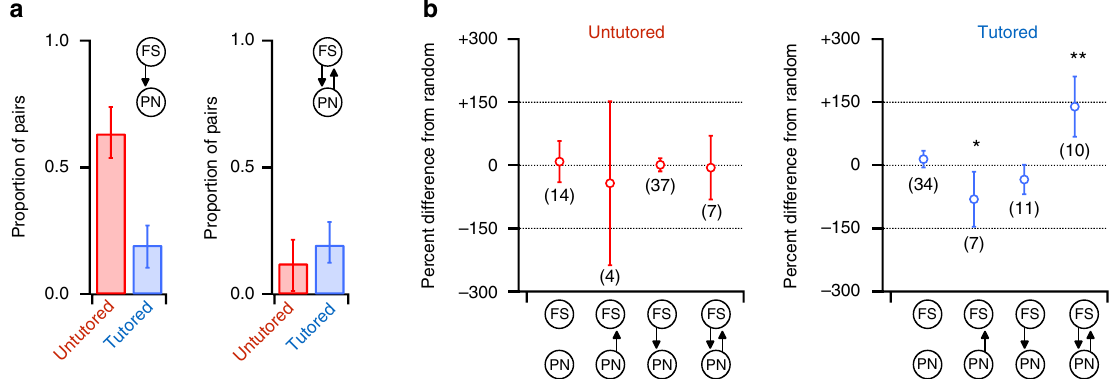
Fig. 3 Enrichment of reciprocal FSI ↔ PN connections during song learning. a Proportion of all tested pairs before (red) and after (blue) tutoring that were unidirectional FSI → PN connections (left) or reciprocal FSI ↔ PN connections (right). Song learning was associated with a 69% reduction in unidirectional FSI → PN connections (binomial test p < 0.001), but did not alter the proportion of reciprocal FSI ↔ PN connections. Error bars indicate 95% con fi dence intervals. b Frequency of fi rst-order connection patterns that we detected in untutored (left, red) and tutored (right, blue) birds relative to each connection pattern ’ s expected frequency given unidirectional FSI → PN and PN → FSI connection probabilities in untutored and tutored birds. Each connection pattern was present at chance levels before tutoring, whereas reciprocal FSI ↔ PN connections were 2.39 times more frequent than predicted by random connectivity after song learning (multinomial test p < 0.01, 95% con fi dence interval = 1.68 – 3.11-fold, see Methods). Correspondingly, one-way PN → FSI connections were 0.41-fold less frequent than predicted after song learning (multinomial test p < 0.05). Relative to untutored birds, tutoring signi fi cantly increased the prevalence of FSI ↔ PN and PN → FSI connections (multinomial test p < 0.005) and reduced the prevalence of FSI → PN connections (multinomial test p < 0.00001). Error bars indicate 95% con fi dence intervals. Connection pattern sample sizes are